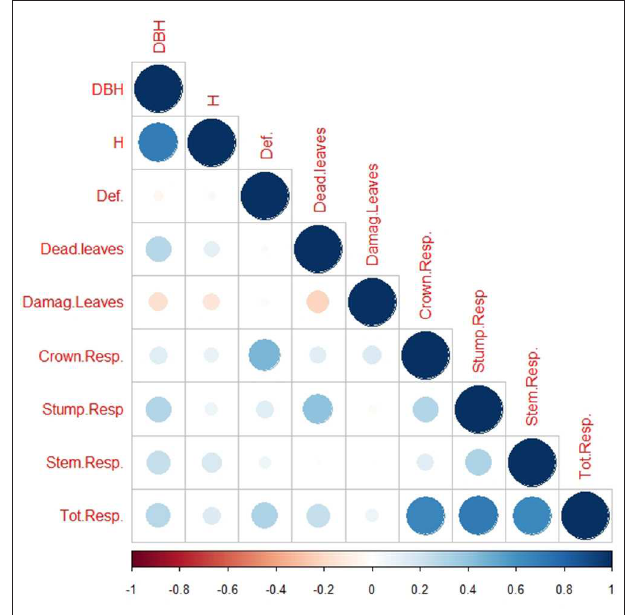
FIGURE 3 | Correlation matrix (non-parametric test, Spearman r ) between the variables assessed in the permanent plots for Quercus ilex and Phillyrea latifolia together. DBH, Diameter at Breast Height; H, Height; Def., defoliation; Dead.leaves, dead leaves (completely dry leaves); Damag.Leaves, damaged leaves (partially dry leaves); Crown.Resp., Stump.Resp., Stem.Resp., Tot.Resp., resprouting from dormant and adventitious buds from the crown, stump, stem and in total. Bar indicates the r